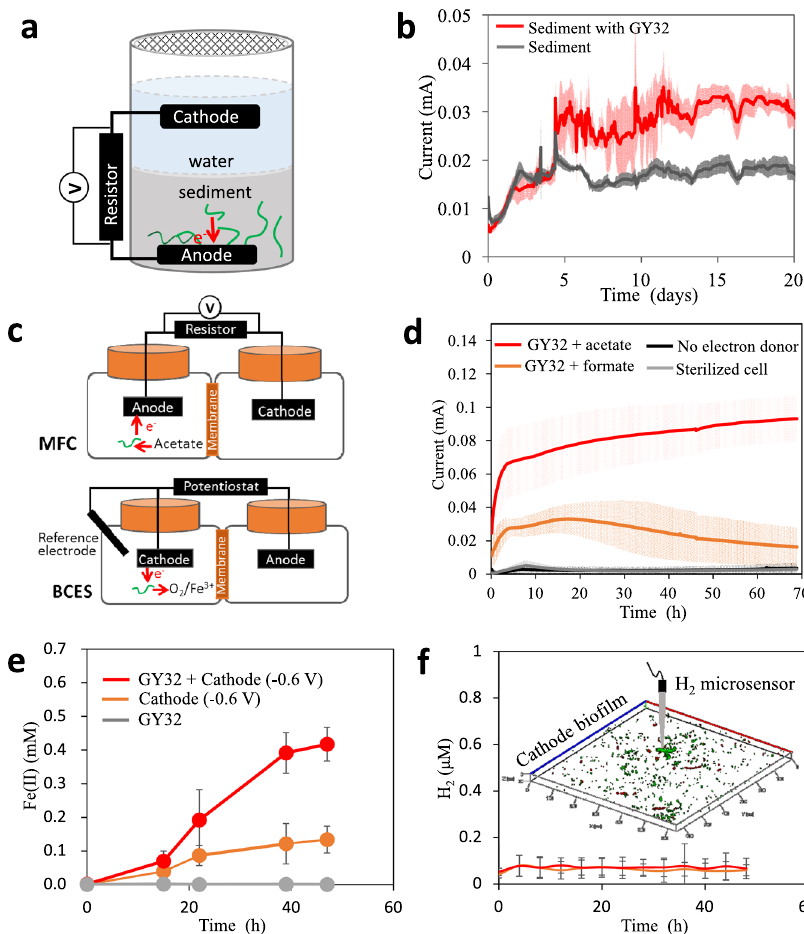
Fig. 2 Bidirectional EET between GY32 and electrodes. a Schematic of GY32 electricity generation in SMFCs. b Electricity generation by inoculating GY32 in SMFCs. c Schematic of GY32 EET in MFCs with liquid medium (upper reactor) and in BCESs (lower reactor). d Electricity generation by GY32 in MFCs with liquid medium. e Fe(III) reduction by GY32 with a cathode ( − 0.6 V vs. SHE) as the sole electron donor in BCESs. f H 2 concentration in the BCESs with or without GY32, inset shows the GY32 bio fi lms on the cathode. n = 3 for each experiment, plots show mean and standard deviation. Source data are provided as a Source Data fi